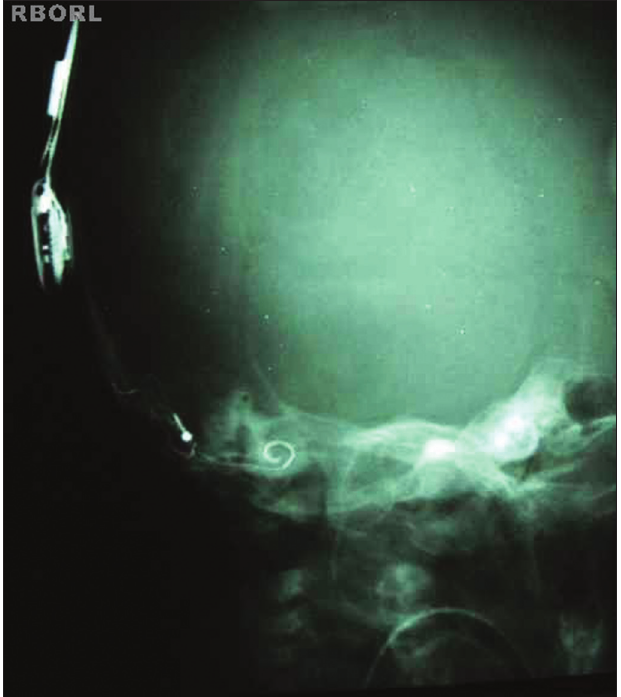
Figura 7. Resultado radiológico esperado (Oblíqua lateral 45 ° ).